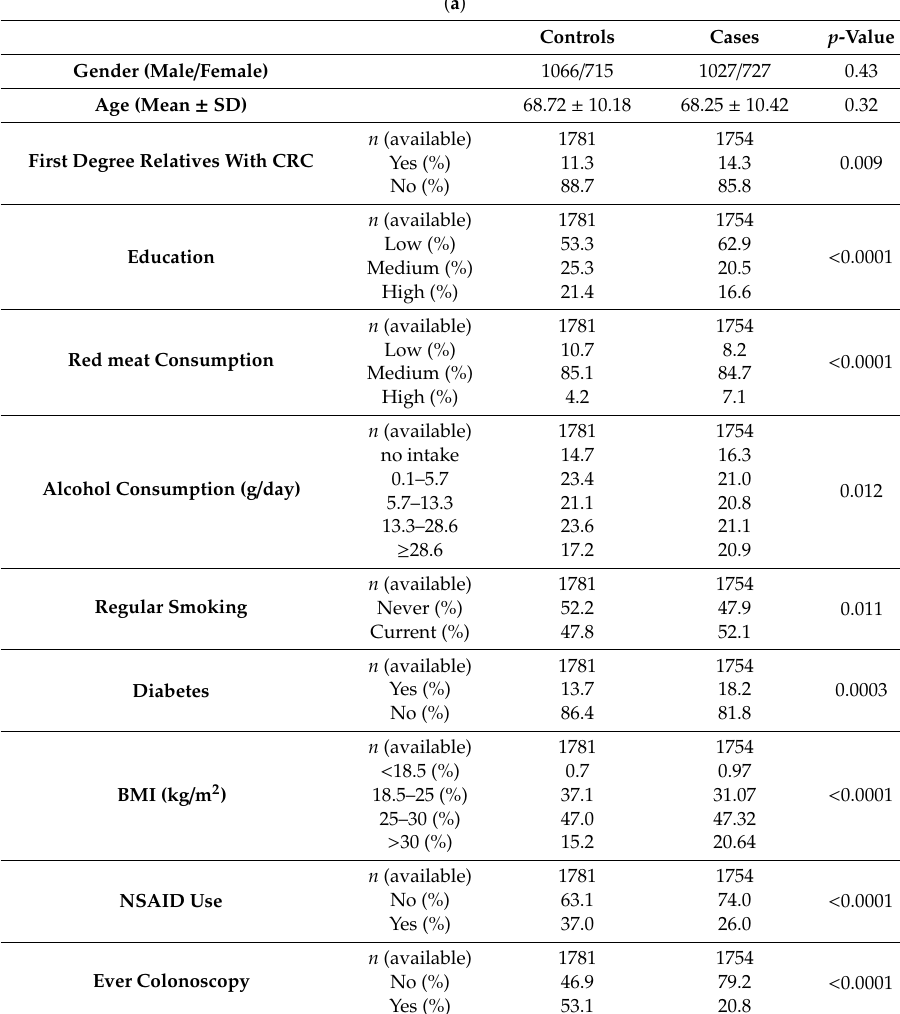
Table 1. Characteristics of the study population. ( a ) Total population; ( b ) Case